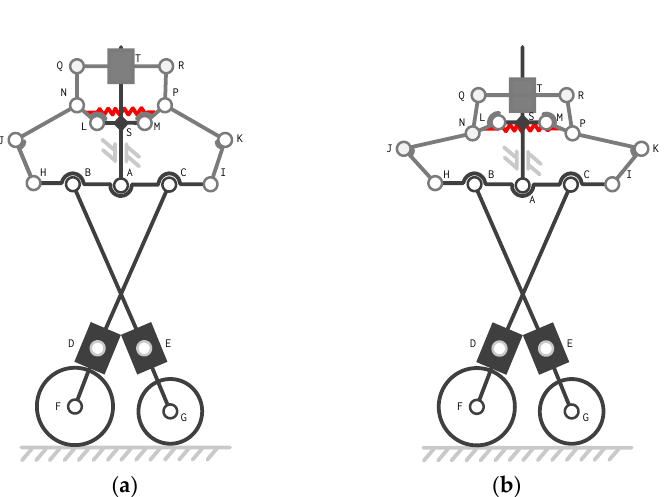
Figure 2. Schematic diagram of the conceptual design in a ( a ) compliant and ( b ) stiff state.